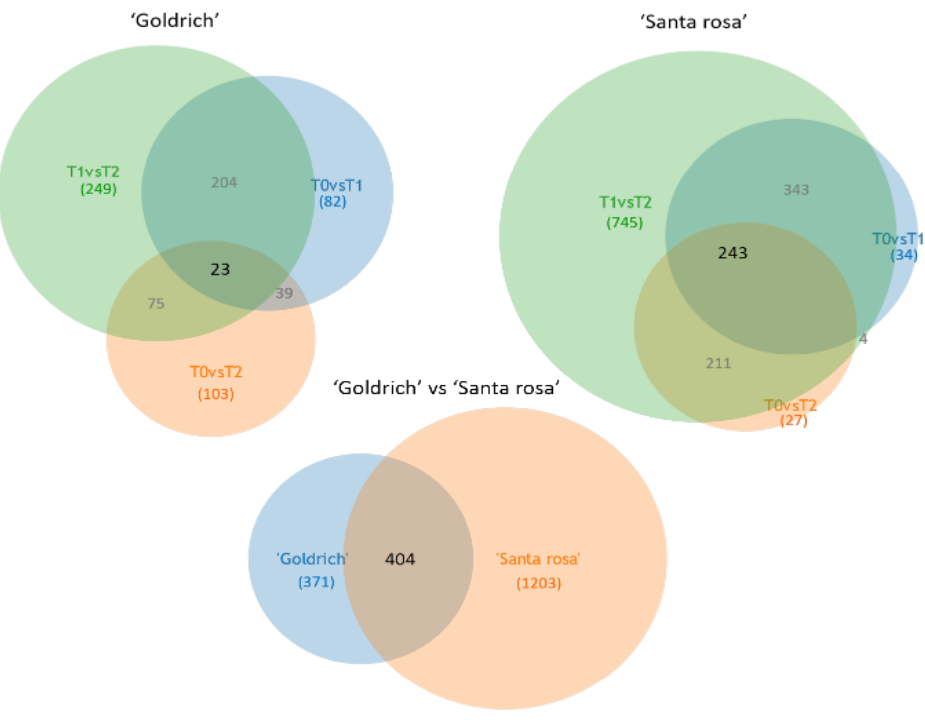
Figure 5. Venn diagrams of genes functionally annotated between treatment comparisons (T0 vs. T1, T0 vs. T1, and T1 vs. T2) and between apricot ‘Goldrich’ and Japanese plum ‘Santa Rosa’ after filtering (DEGs, − 1 > log2FC > 1; p -value < 0.005).